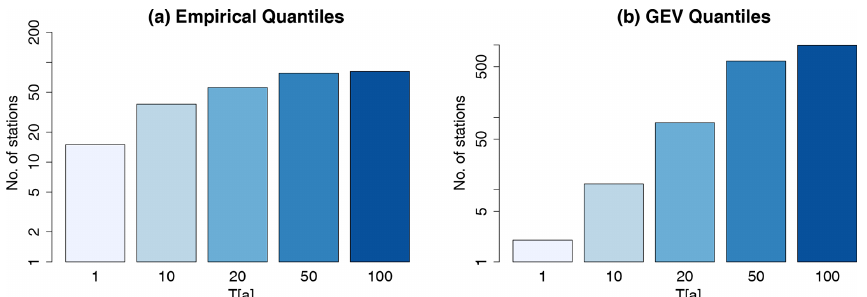
Figure 6. Number of all stations at a 5min resolution (for both short and long series) for different return periods (T[a]) showing quantile crossings in the empirically calculated quantiles (a) and the GEV-fitted quantiles (b) with increasing duration.